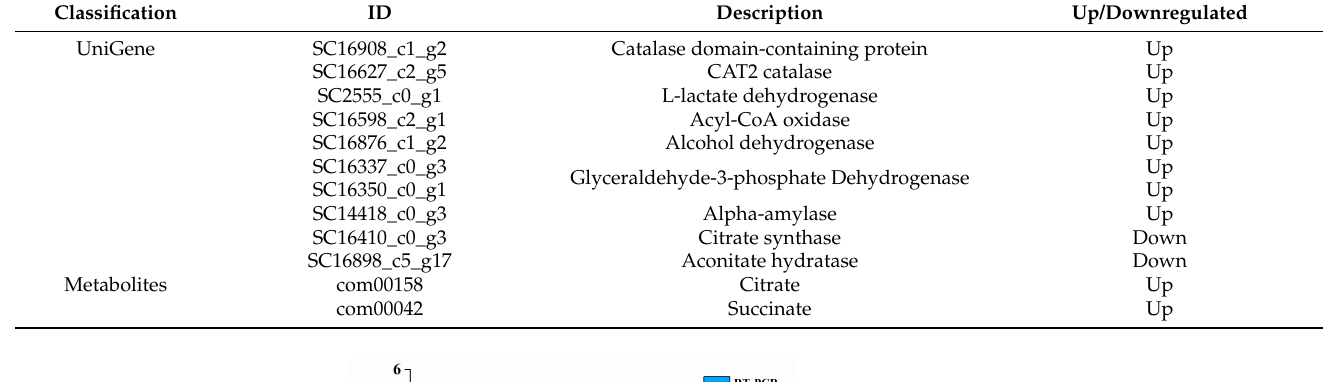
Table 2. Key genes and metabolites for SC resistance to adversity from integration analysis of metabolomic and transcriptomic data.